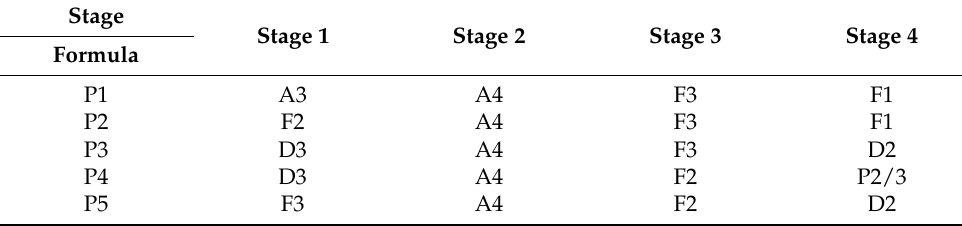
Table 8. Reaction model of four stages during the pyrolysis of Samples P1–P5.